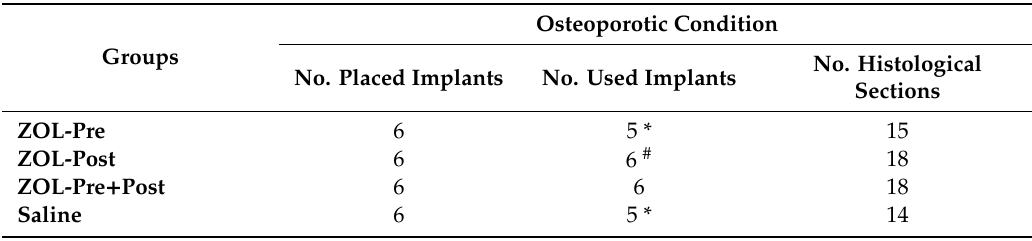
Table 1. Summary of implants placed and submitted to histological evaluation. ZOL, zoledronate. Groups